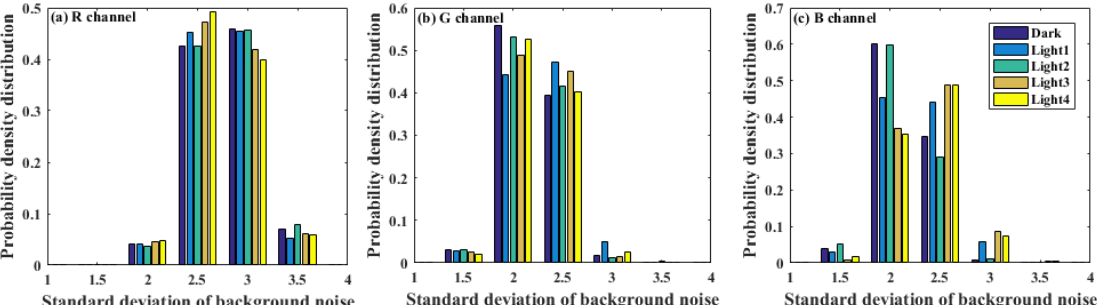
Figure 6. Probability density distributions of the standard deviation of background noise in RGB channels under different ambient light conditions (Dark, Light 1, Light 2, Light 3 and Light 4) from weak to strong.